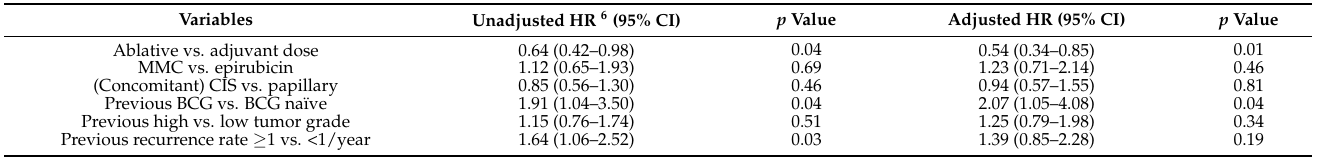
Figure 2. Recurrence free survival (RFS) and durable response combined after RF-CHT for ablative dose group and adjuvant dose group. Patients treated with ablative dose had significant better RFS and durable response (univariable analysis p = 0.04). Table 4. Multivariable analysis of recurrence free survival and durable response.